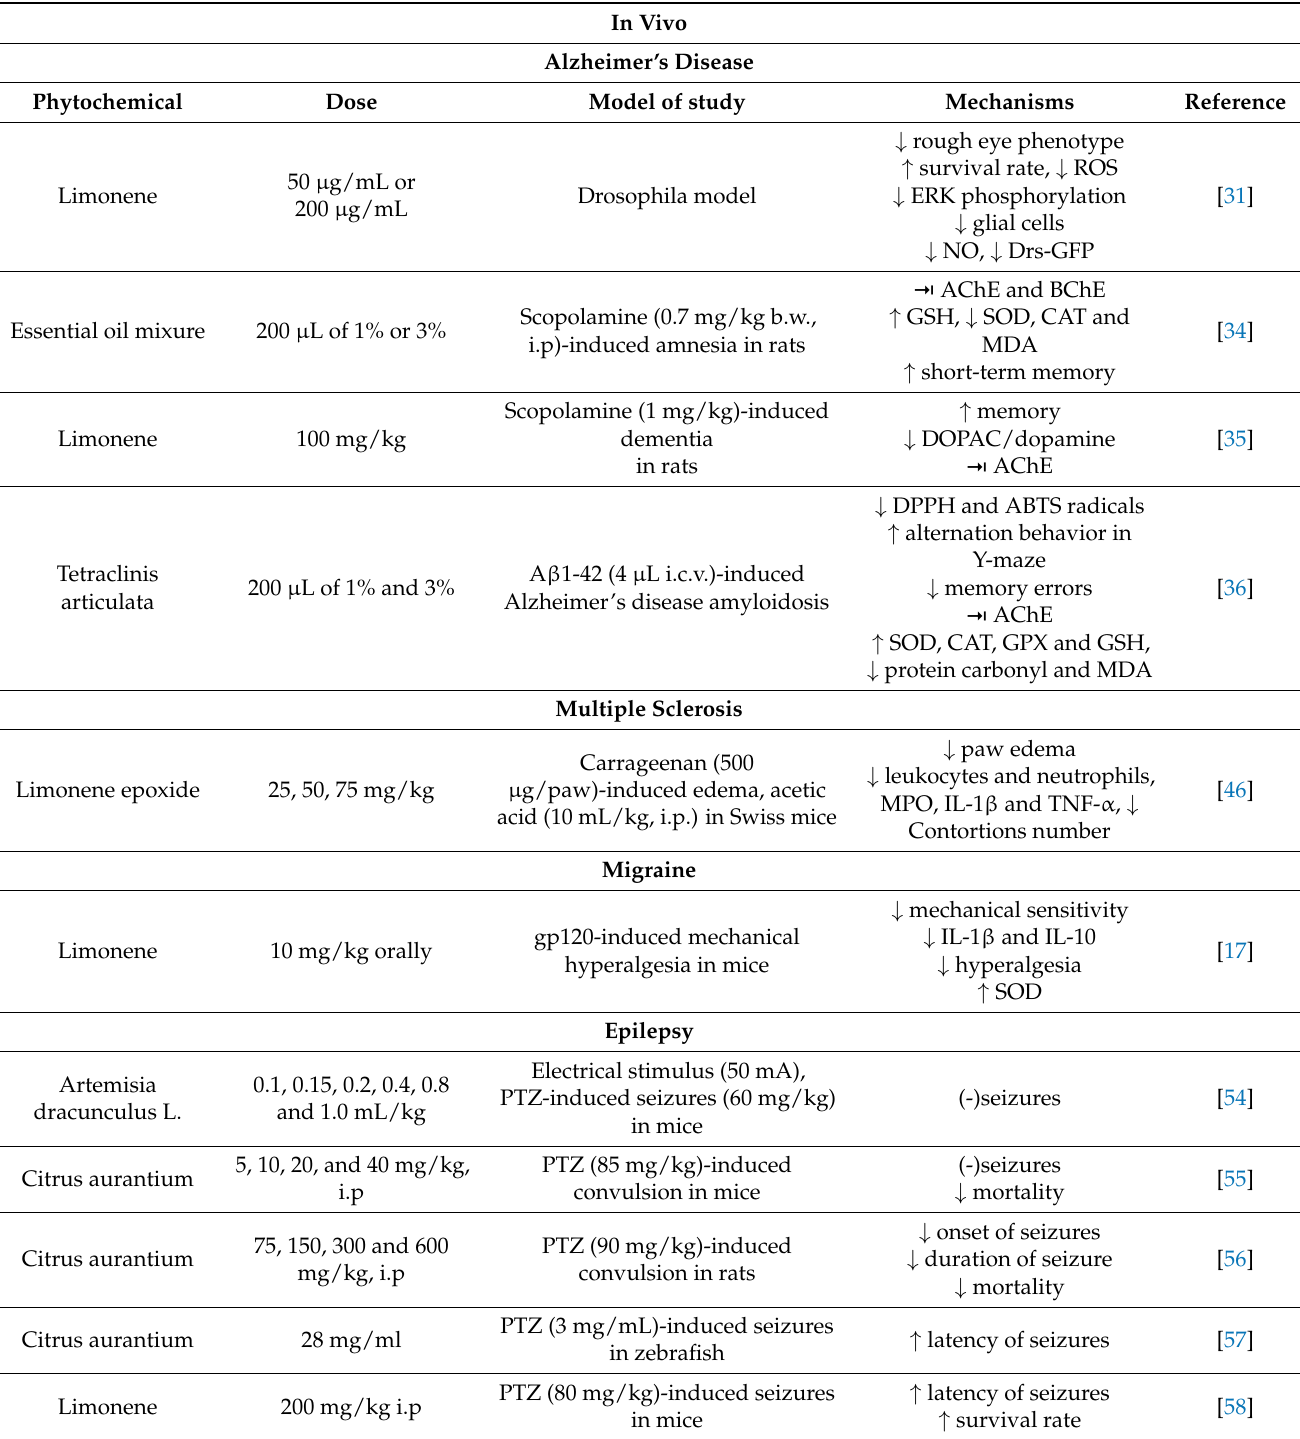
Table 3. The in vivo studies showing the neuroprotective effects of limonene.